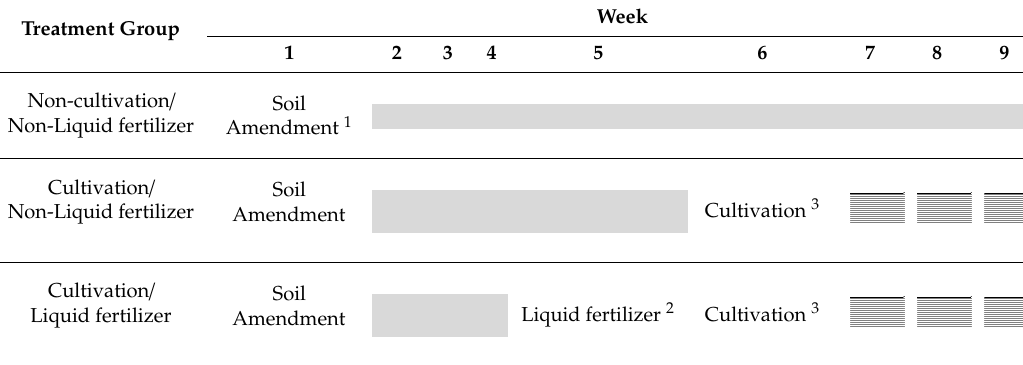
Table 1. Experimental design and process.